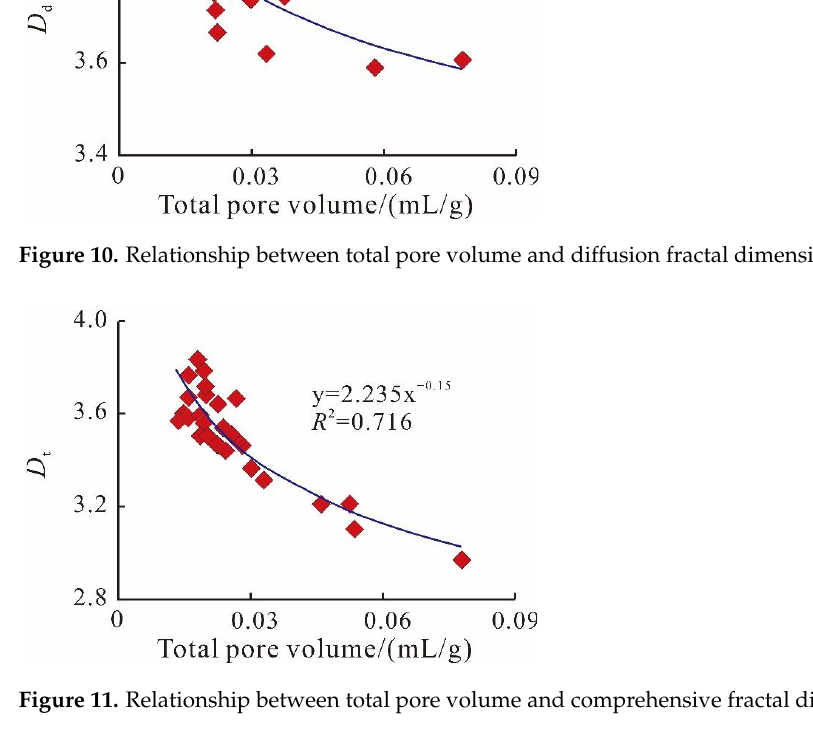
Figure 11. Relationship between total pore volume and comprehensive fractal dimension ( D t ).